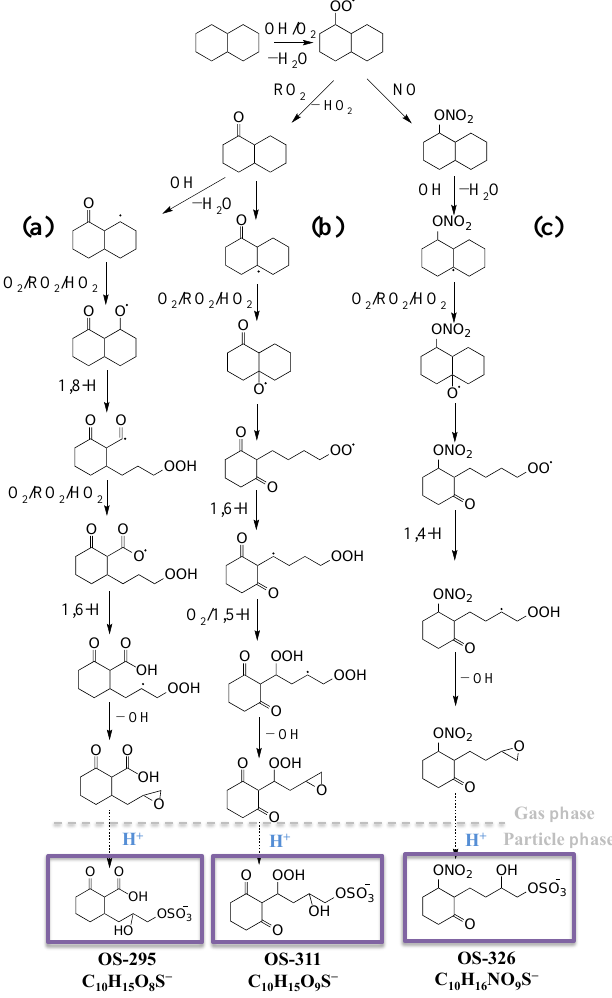
Figure 4. Tentatively proposed formation pathways of OS-295 (295.0494), OS-311 ( m/z 311.0447) and OS-326 (326.0554) from the oxidation of decalin in the presence of sulfate aerosol.